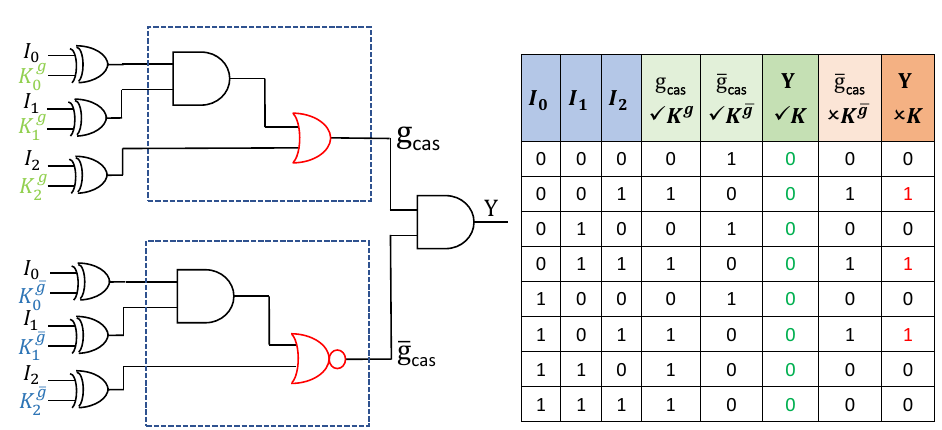
Figure 13: CAS-Lock with Maximum Output